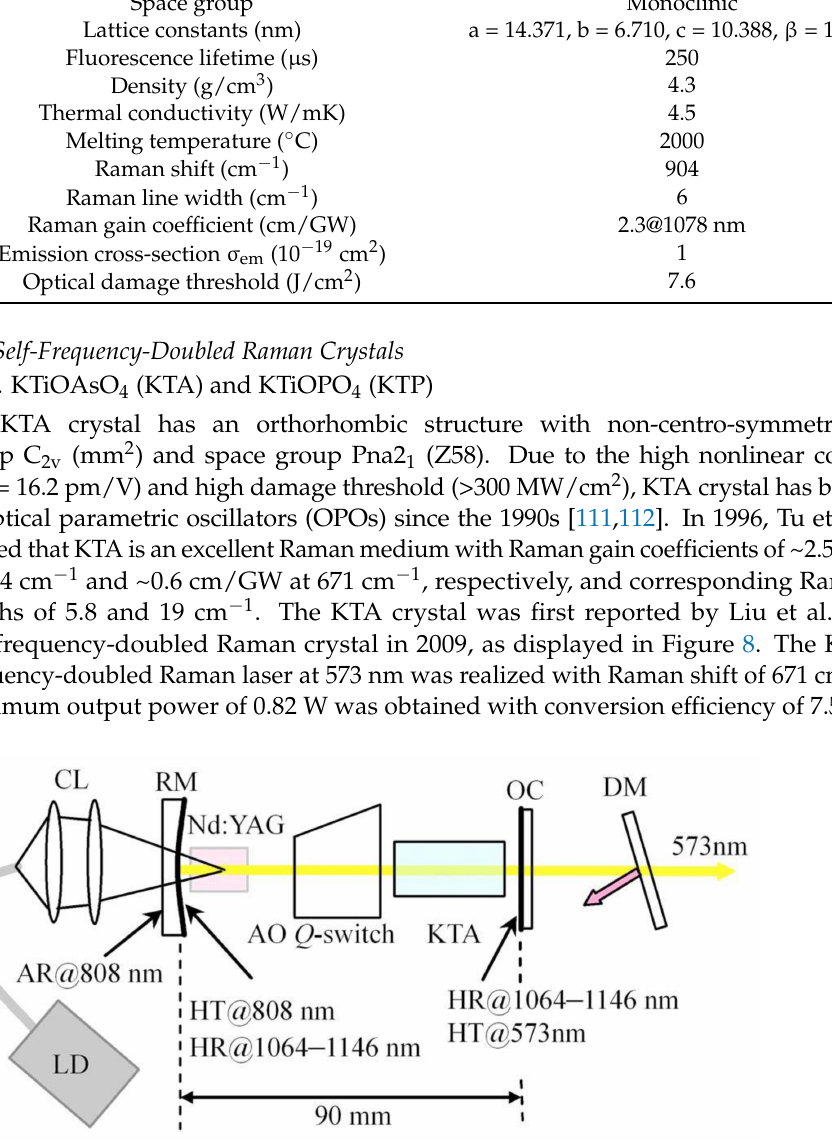
Figure 8. Schematic diagram of the KTiOAsO 4 ( KTA) self-frequency-doubled Raman laser [5]: LD, laser diode; CL, coupling lens; RM, rear mirror; OC, output coupler; DM, dichroic mirror;